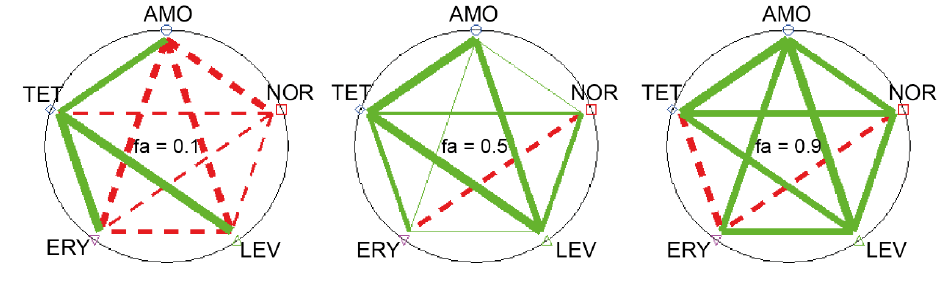
Figure 3. Polygonograms showing pair-interactions among 5 antibiotics for three selected effect levels, fa (0.1, 0.5, and 0.9) in the bioluminescent cyanobacterium Anabaena CPB4337 (elaborated based on the data published in [38]). AMO: Amoxicillin; NOR: Norfloxacin; LEV: Levofloxacin; ERY: Erythromycin; TET: Tetracycline. Green lines denote synergism and red lines antagonism. The thickness of the lines indicates the strength of the interactions, (thickness scales according to [5]). The polygonogram allows an effect-oriented visualization of the nature of the combination effect of mixtures. Here binary mixtures (line connectors) are presented. However higher than two component interactions can also be graphically presented. For example, ternary mixture interactions can be represented showing triangles among three chemicals, quaternary by squares, etc